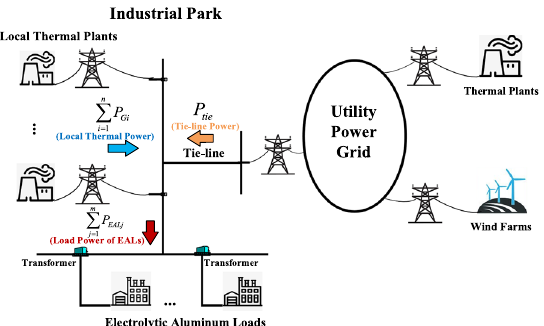
Fig. 1 The structure of an industrial park with